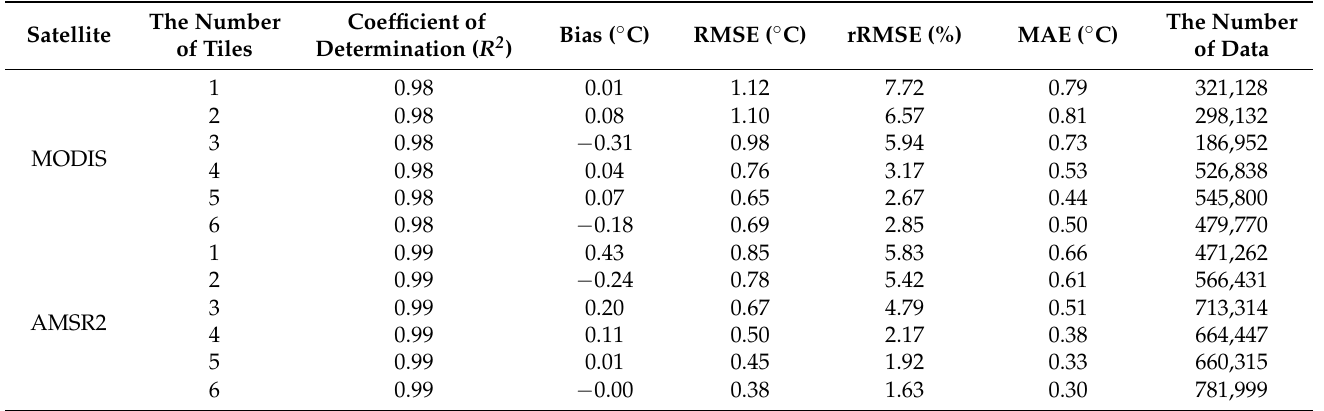
Table 4. Validation accuracy of the MODIS and AMSR2 SST reconstructions for each